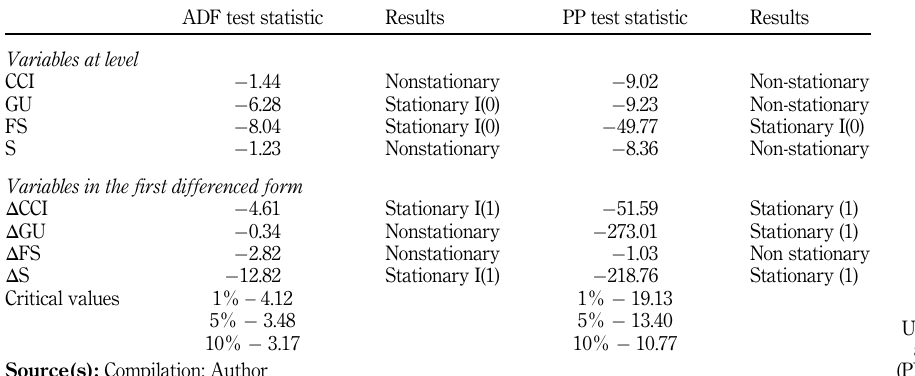
Table 3. Unit Root Test: ADF